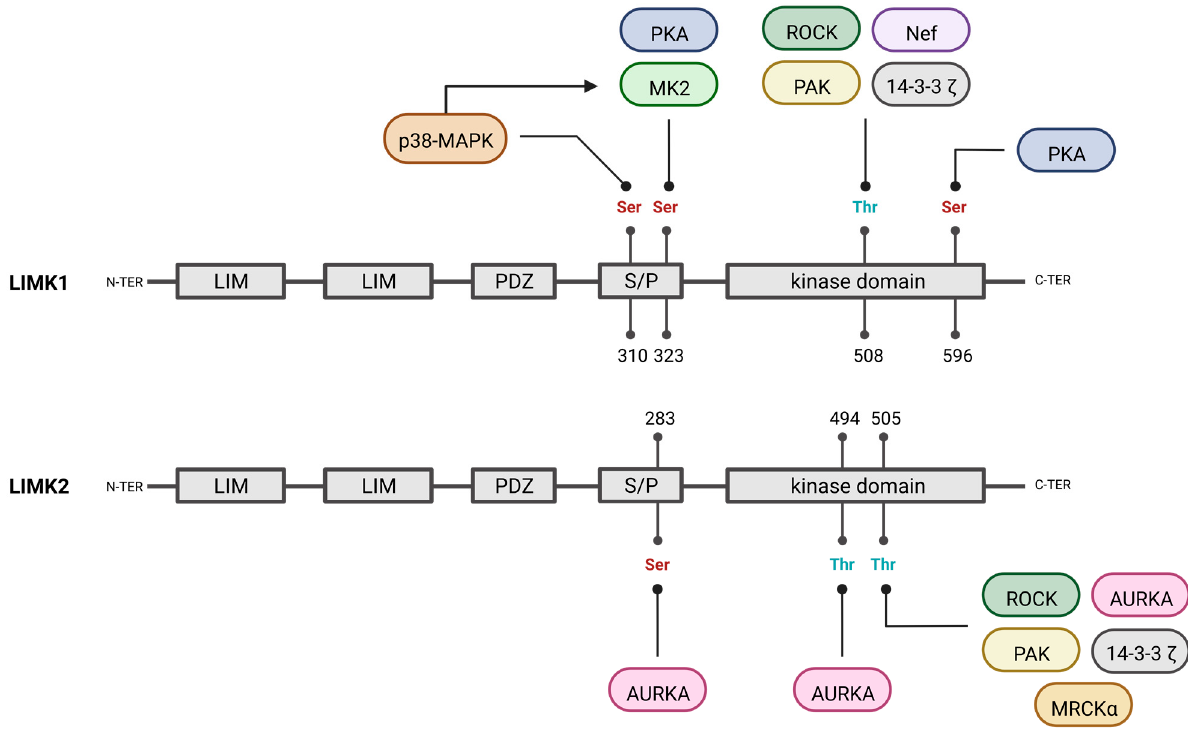
Figure 3. LIM kinase known phosphorylation sites and the kinases involved in these processes.